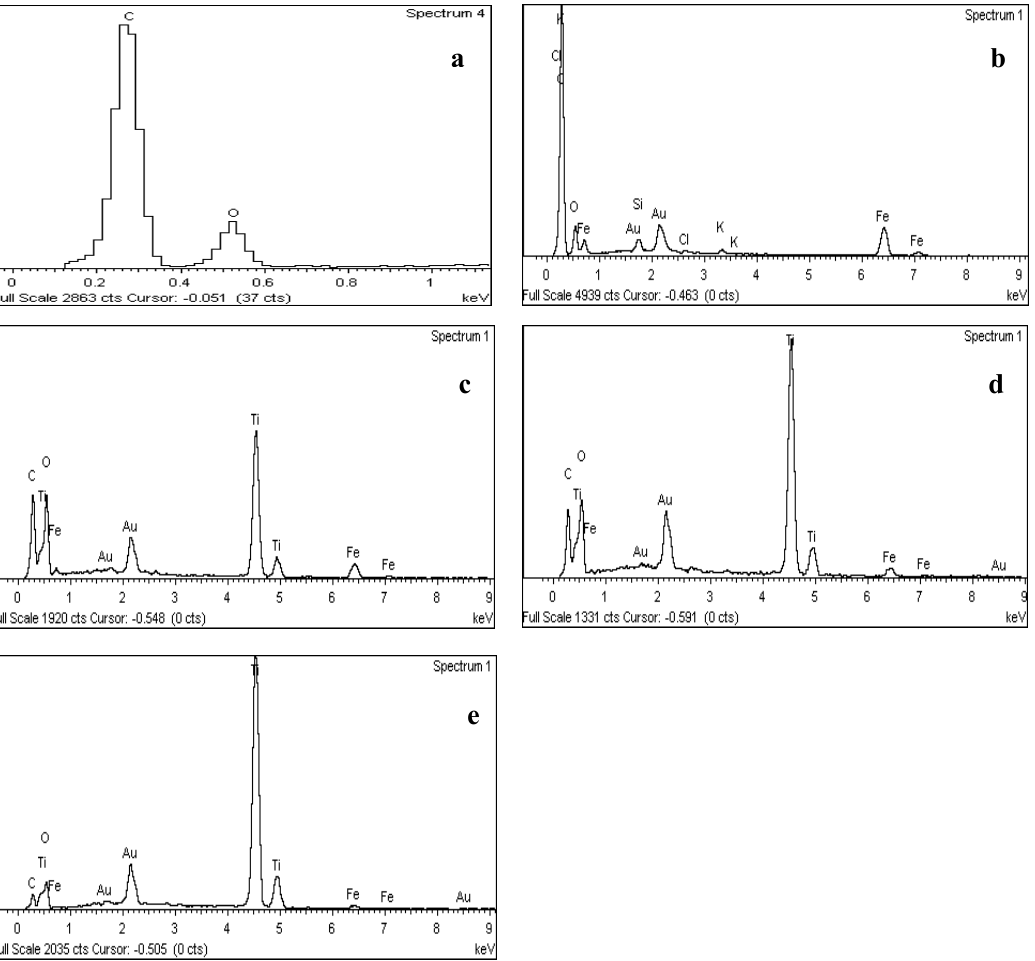
Figure 4. EDX spectra of ( a ) synthesised AC and ( b ) Fe 3 O 4 /AC and Fe 3 O 4 /AC/TiO 2 in different ratios of ( c ) 1:1, ( d ) 1:2, and ( e ) 1:4.